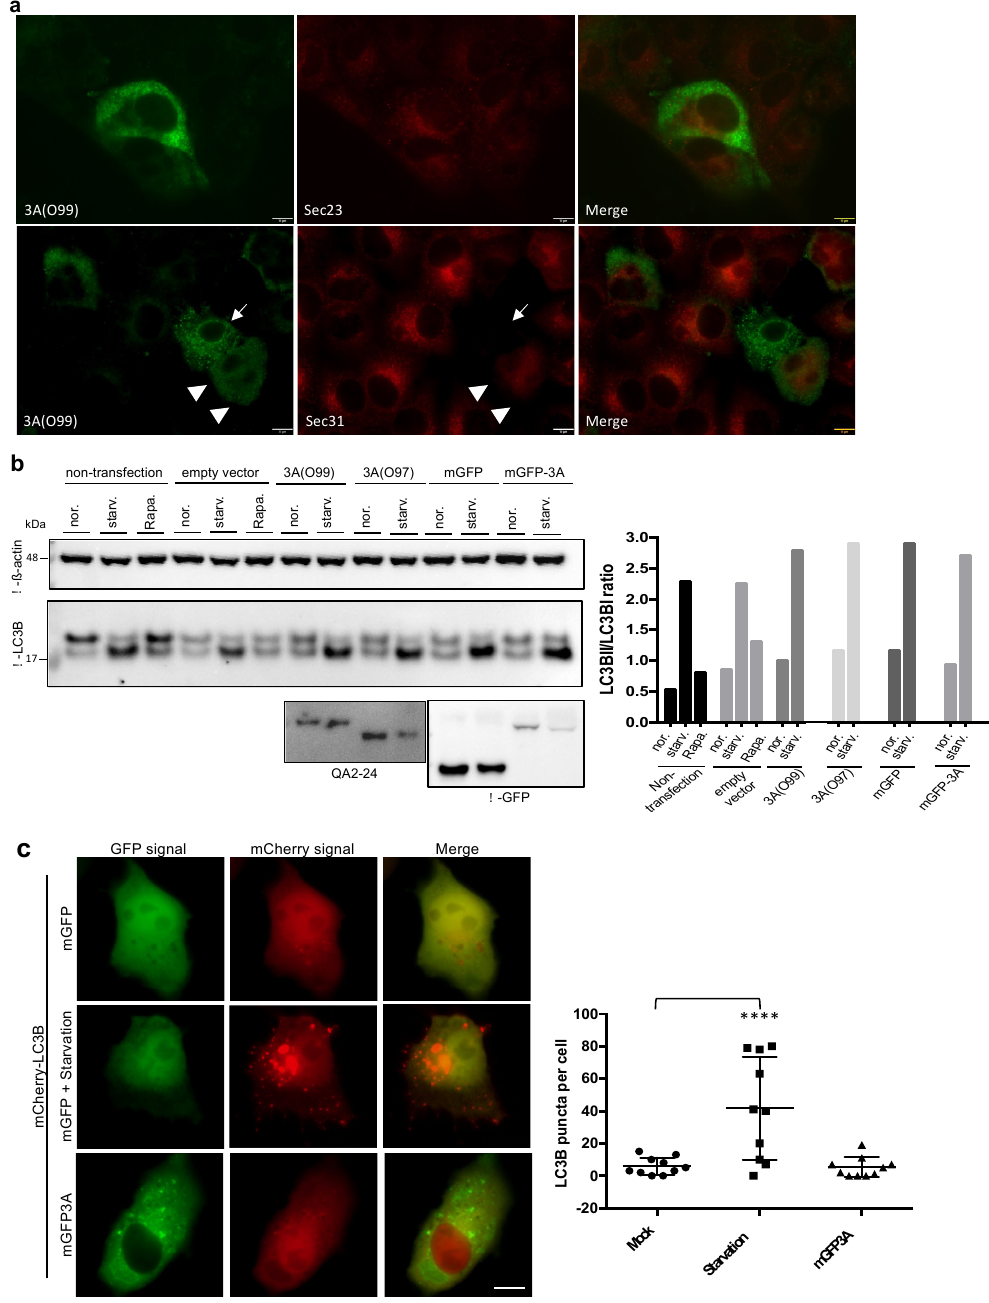
Figure 3. ( a ) PK-15 cells expressing 3A (O99) were stained with specific anti-Sec23A or Sec31A rabbit antibodies, followed by anti-rabbit antibodies conjugated with Alexa Flour 594. Finally, the 3A (O99) protein was further identified using QA2-Dylight488. The white arrow indicates the cell expressing 3A showing downregulation of Sec31, while white arrowheads indicate those showing Sec31 dispersion. ( b ) PK-15 cells were transfected using an empty vector (pcDNA-3.1(+)), pcDNA-mGFP, pcDNA-3A, or pcDNA-mGFP-3A for 21 h. The cells were further incubated in either normal, 100 nM rapamycin, or starvation condition medium for 3 h. The LC3B proteins from these cell lysates were analyzed by Western blotting and quantified using the ImageJ software. ( c ) PK-15 cells co-expressing mCherry-LC3B with mGFP or mGFP-3A. The cells expressing mGFP in starvation condition medium for 3 h were regarded as a positive control for autophagy activation and showed much more LC3B punctae than did the non-treated cells, but there was no significant increase in mGFP-3A overexpression. Scale bar, 10 µm. **** p < 0.0001.